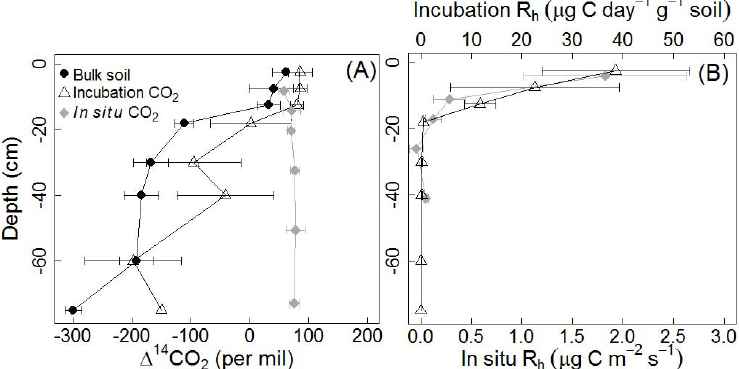
Fig. 9. (a) 1 14 C of bulk solid soil, CO 2 respired in laboratory incubations, and soil air CO 2 from trenched plot (note the respiration units differ for field and laboratory samples). (b) CO 2 production rate in incubations and in trenched plot. Error bars for bulk soil and laboratory incubations are the standard deviation of replicate cores ( N = 3), and for the trenched plot are the standard deviation of sampling dates ( N = 10).